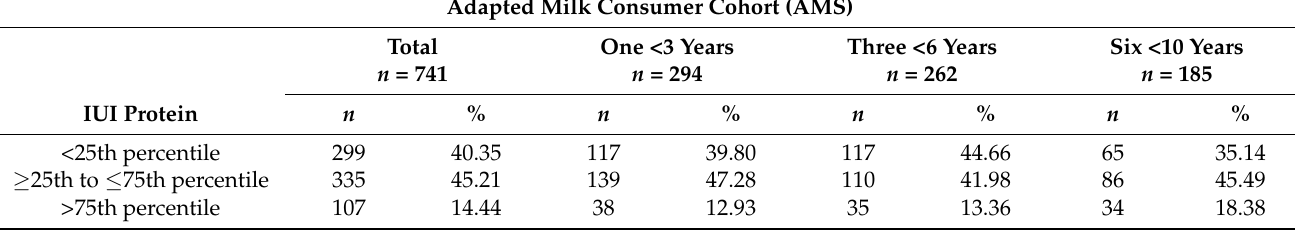
Table 6. Percentage of children with a below P25, between P25 and P75, and above P75 of the individual usual intake of protein in the adapted milk consumers cohort ( n =